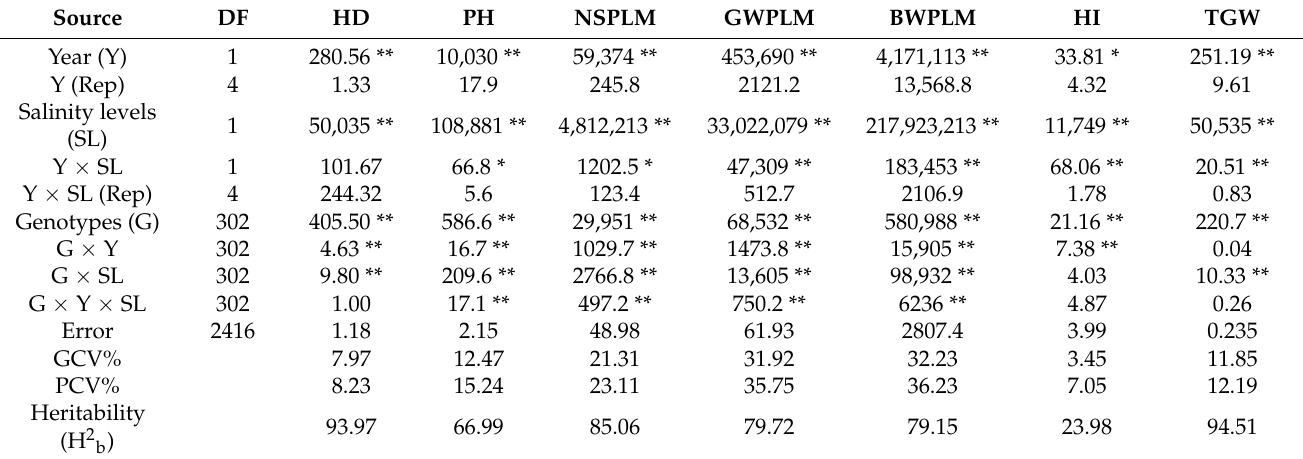
Table 3. Analysis of variance, genotypic coefficient of variation (GCV%), phenotypic coefficient of variation (PCV%), and broad-sense heritability estimates (H 2 b ) for all studied traits under salinity levels and over growing